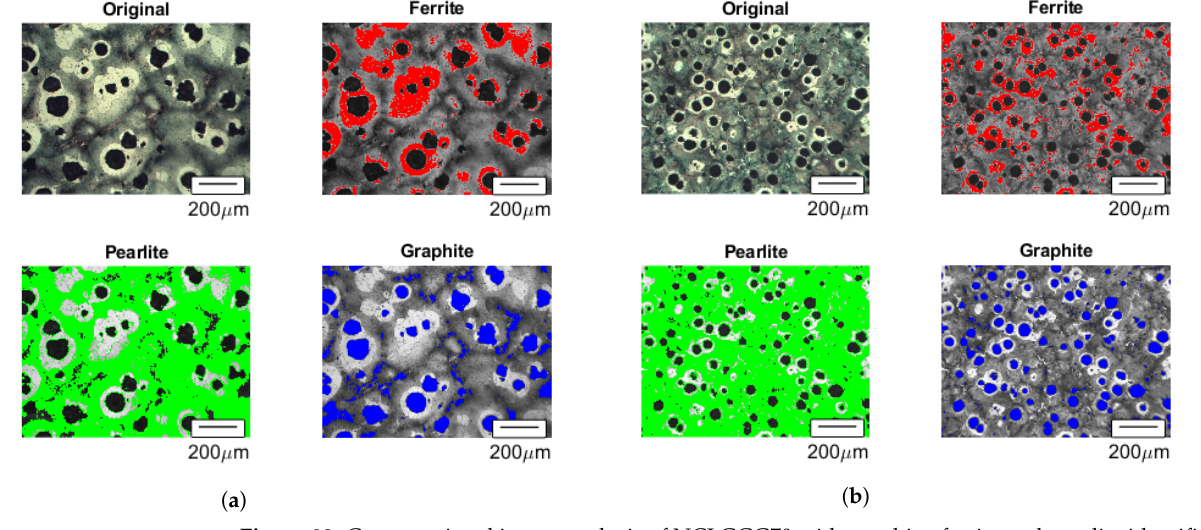
Figure 23. Computational image analysis of NCI GGG70 with graphite, ferrite and pearlite identifica- tion for round bar specimens. ( a ) Block specimens. ( b ) Round bar specimens.